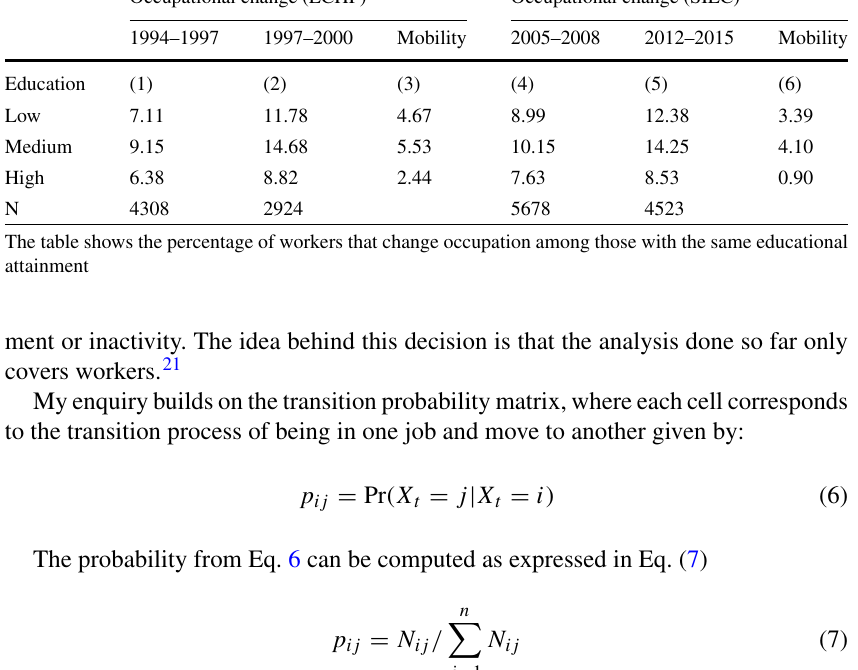
Table 10 Occupational change by educational group. Sources : author’s analysis from the Spanish Labour Force Survey, the European Community Household Panel, and the Survey of Income and Living Conditions Occupational change